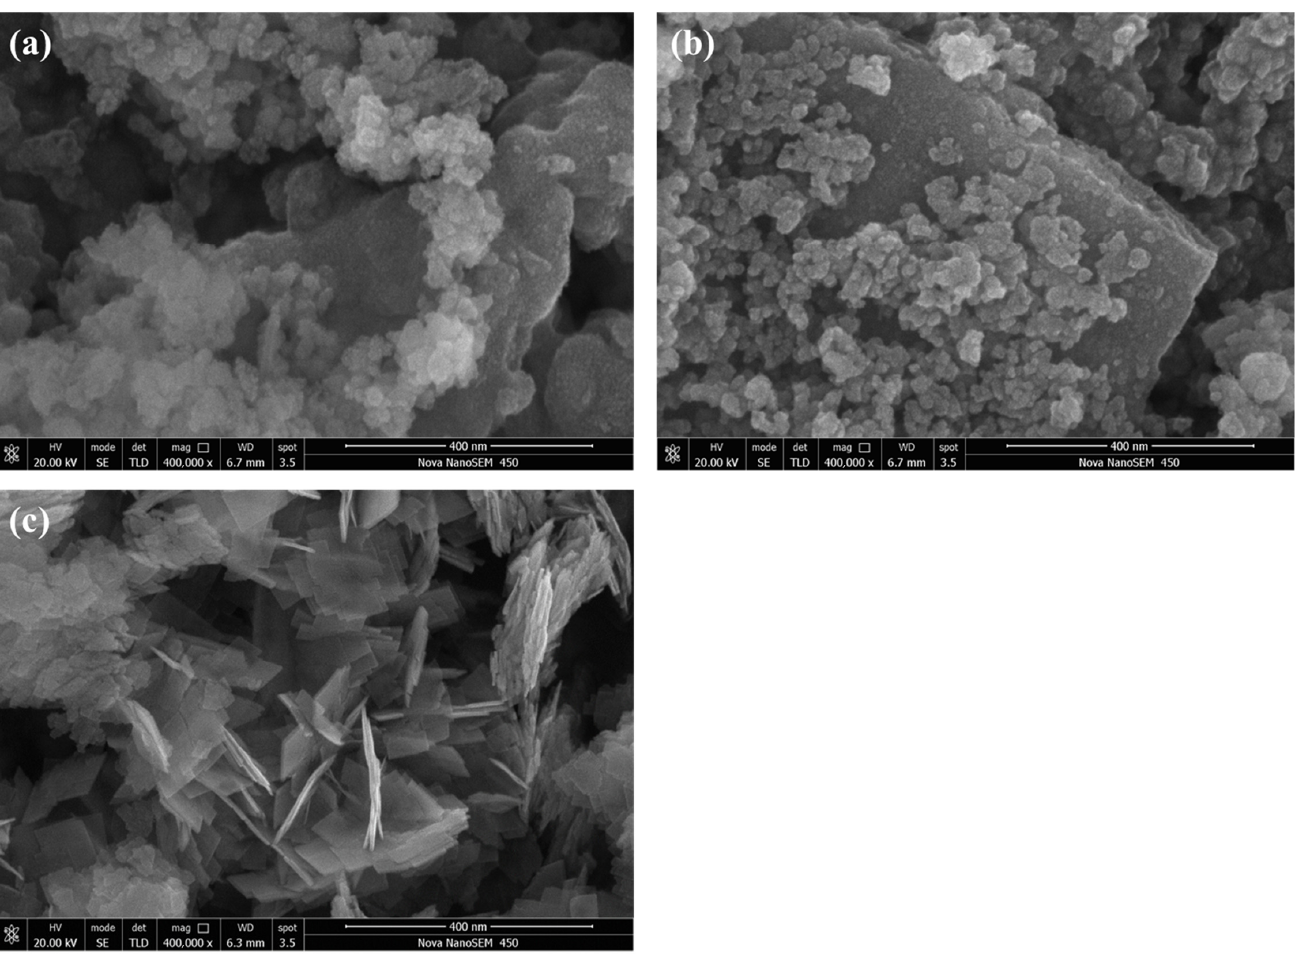
Figure1. SEM images of ( a ) Bi 2 WO 6 , ( b ) Ti-Bi 2 WO 6 , and ( c ) Ni-Bi 2 WO 6 . Figure 1. SEM images of ( a ) Bi 2 WO 6 , ( b ) Ti-Bi 2 WO 6 , and ( c ) Ni-Bi 2 WO 6